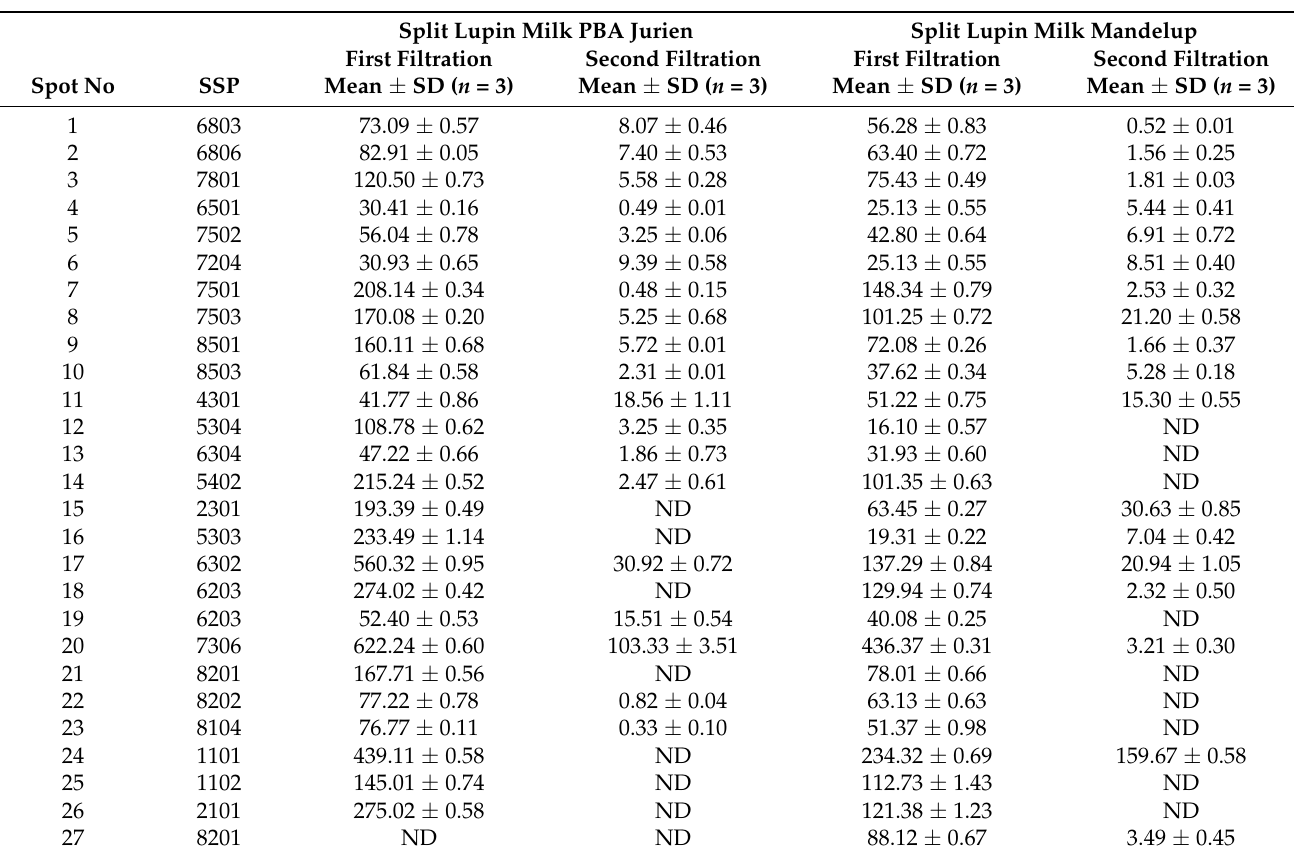
Table 2. Quantitative list of each identified protein spots with respect to extractability in the lupin milk made from the first and second filtrations from both cultivars. The spots are significantly different ( p < 0.05) at PDQuest